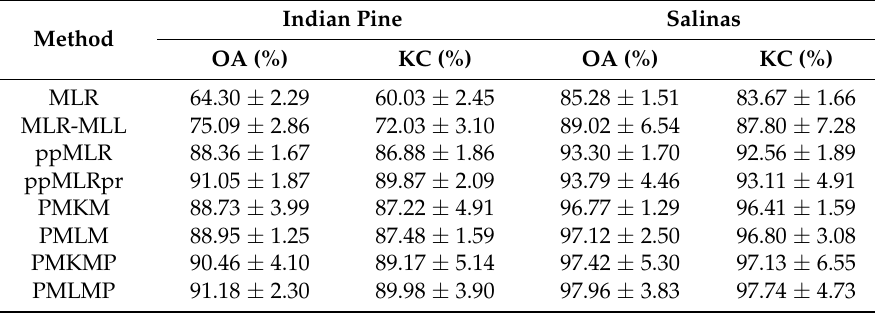
Table 4. Comparison results of several methods on two hyperspectral datasets.